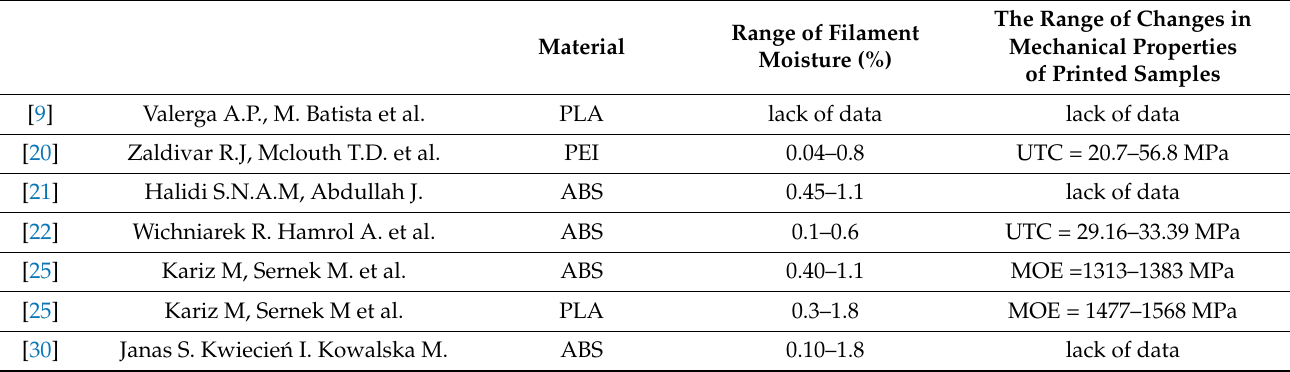
Table 1. Summary of literature